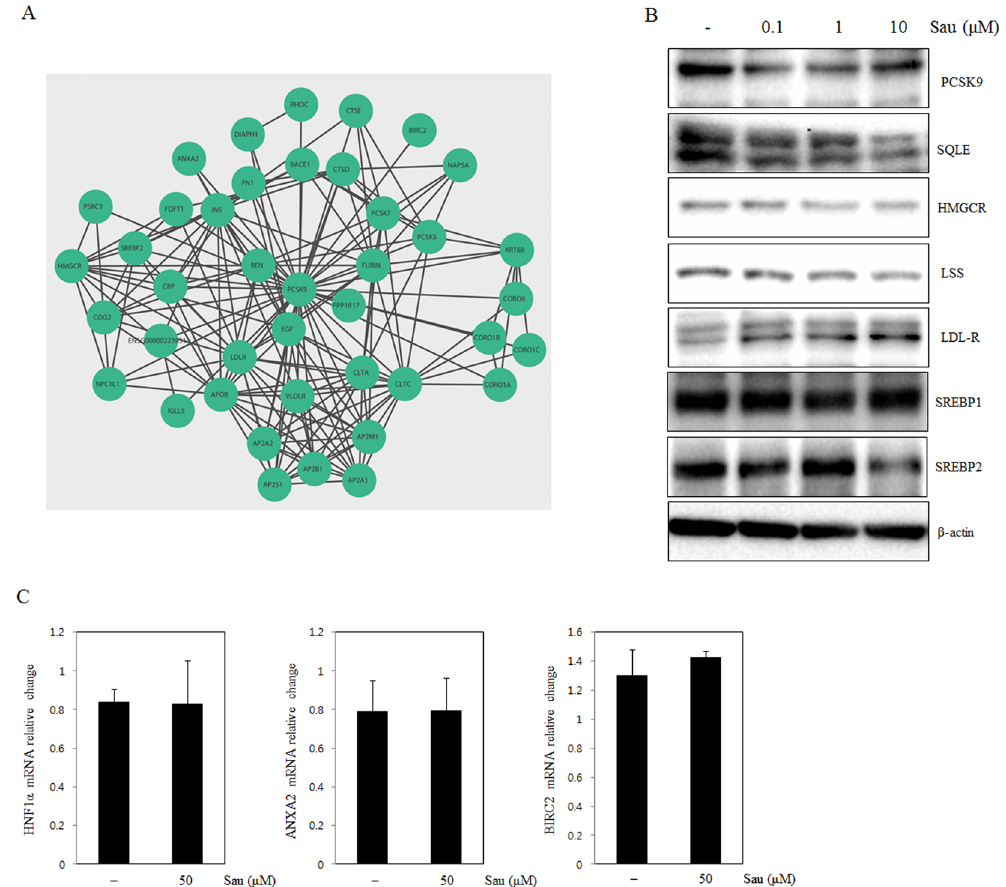
Figure 3. Modulation of the cholesterol signaling pathway in HepG2 cells treated with sauchinone. ( A ) PCSK9 molecular network, obtained with Cytoscape v. 3.5.1 56 using STRING database 57 . ( B ) PCSK9 signaling pathway and associated changes assessed by western blot analysis. ( C ) Genes known to interact with PCSK9 such as HNF1 α , ANXA2 and BIRC2 change in mRNA levels assessed by qRT-PCR